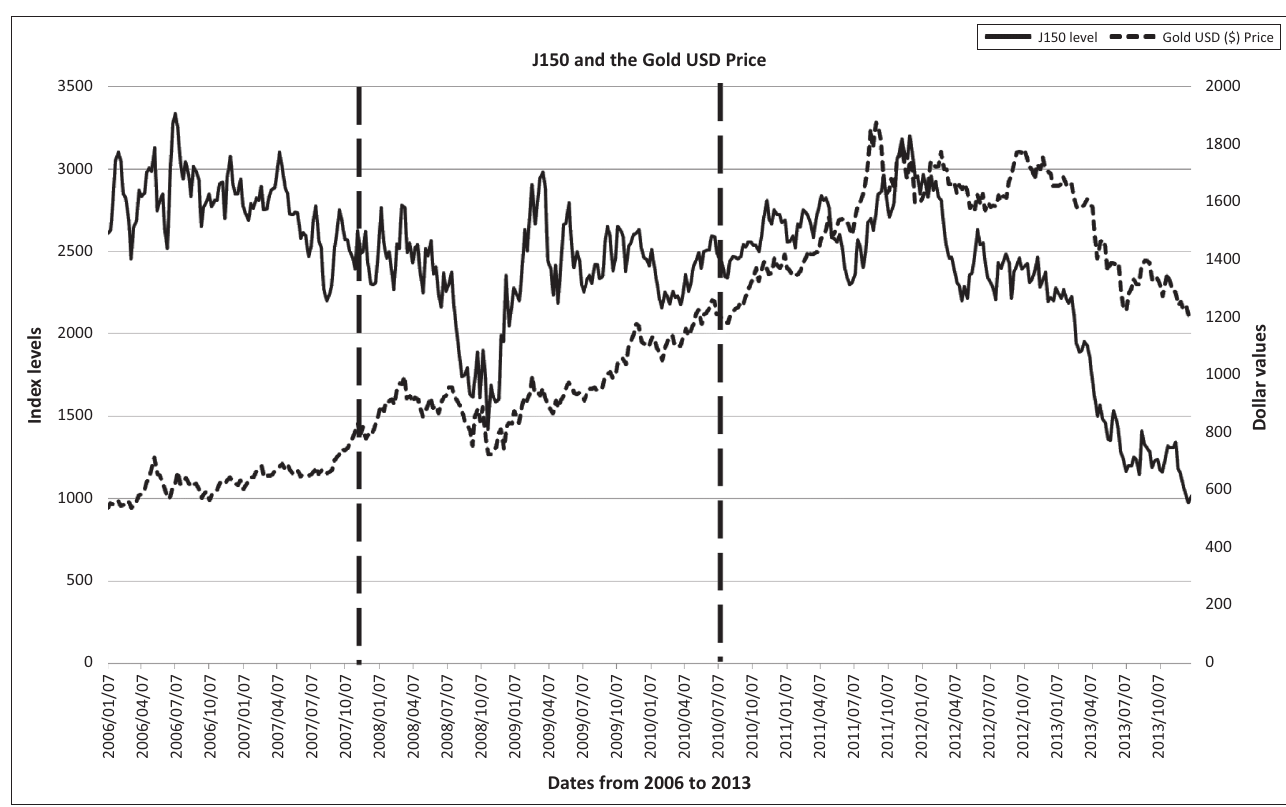
FIGURE 1: Movement in the JSE Gold Mining Index (J150) and the gold price in dollars (January 2006 to December 2013). J150, Johannesburg Stock Exchange Gold Mining